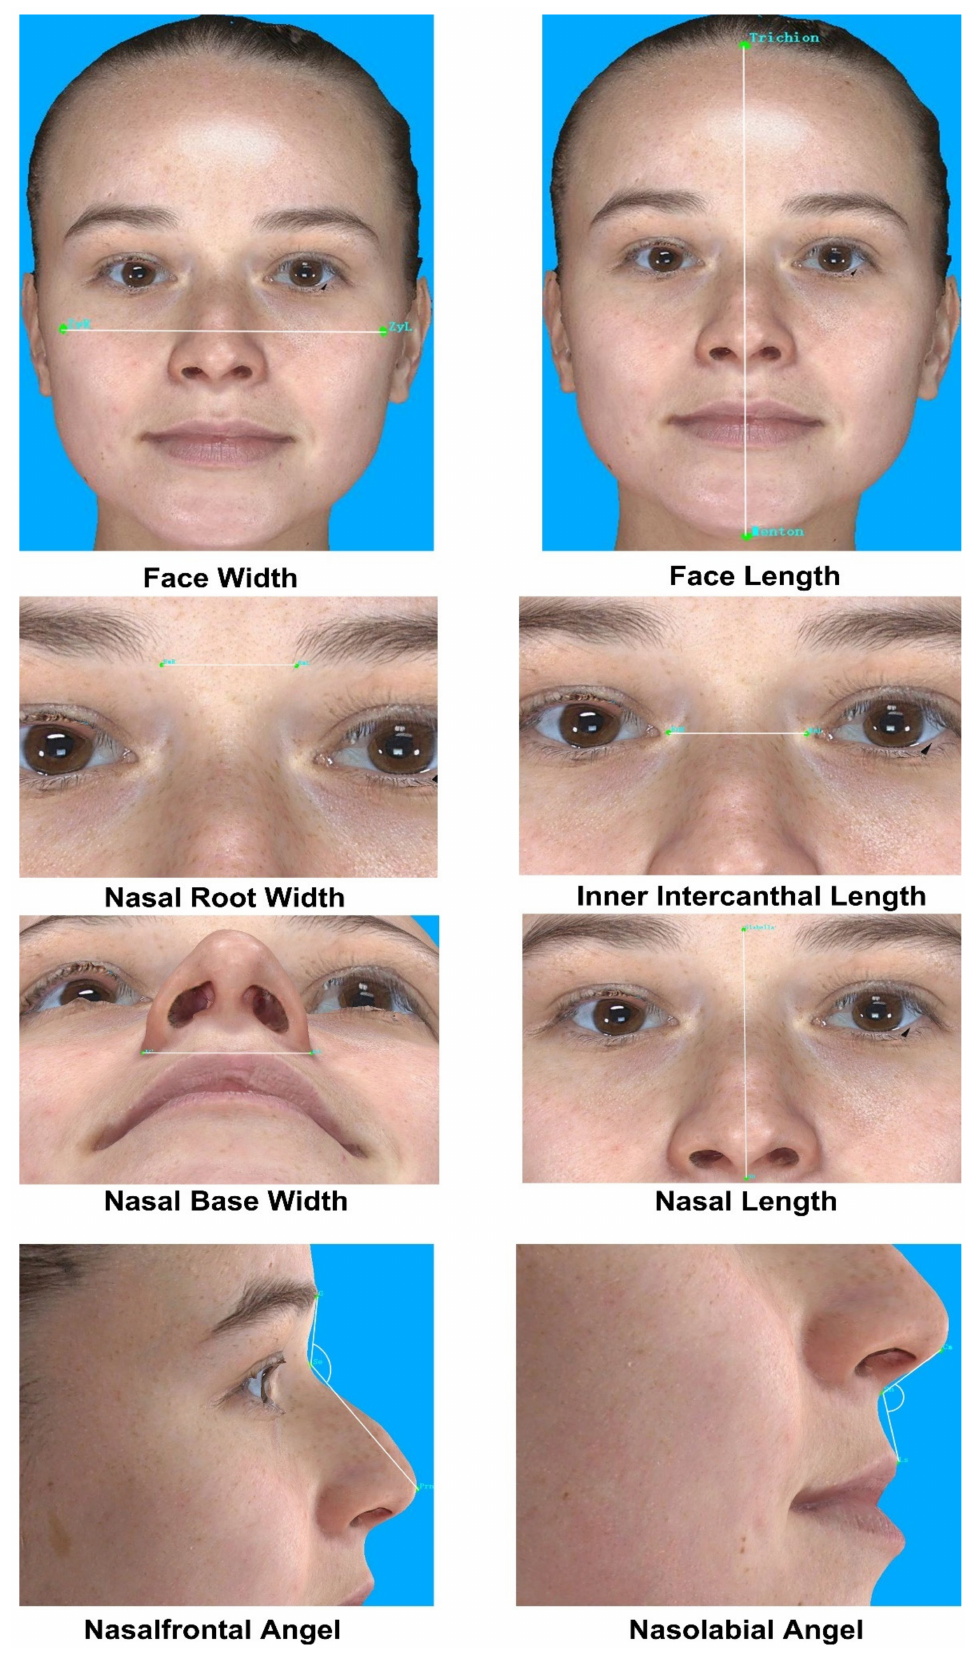
Figure 2. Classic